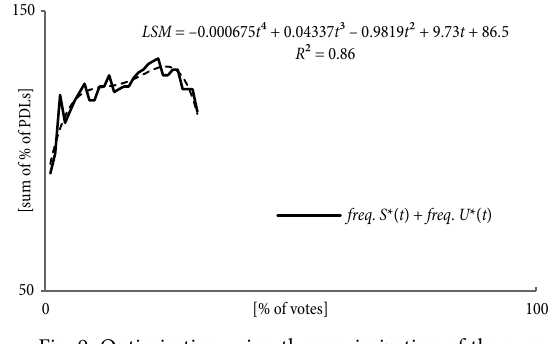
Fig. 9. Optimisation using the maximization of the sum of frequencies of hits